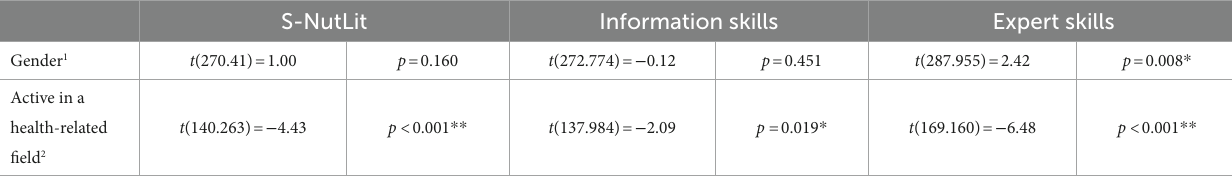
TABLE 4 T-tests of S-NutLit and the two subscales for gender and participants active in a health-related field. S-NutLit Information skills Expert